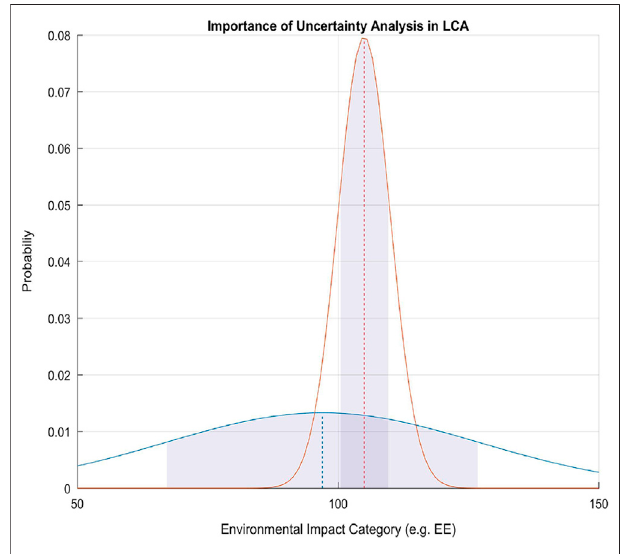
FIGURE 1 | Importance of uncertainty characterisation in life cycle assessment (LCA). A mere comparison between the average of the orange curve and the average of the blue curve could lead to thinking that the “ blue ” value is “ better ” but the complete characterisation of uncertainty reveals a much more ambiguous evidence to choose from. Shaded areas represent ± 1 standard deviation from the mean (dashed lines). Source: (Pomponi et al.,